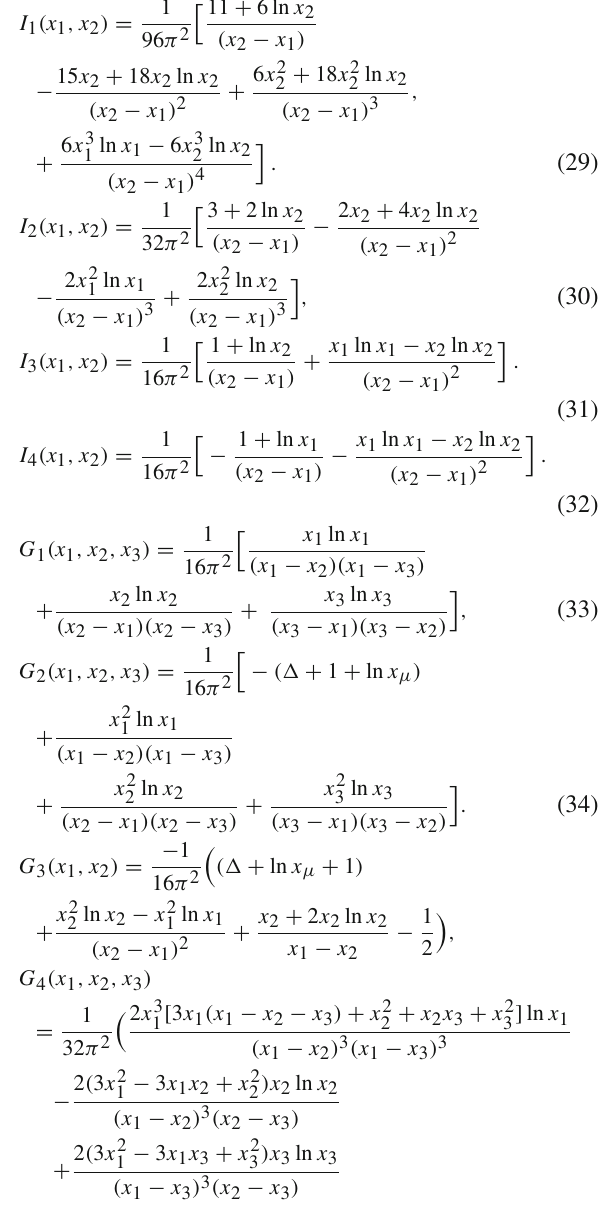
Fig. 10 With m 1 = 500GeV , m 2 = 1000GeV , tan β = 13 , M Lf = 10 4 GeV 2 , tan β L = 2 . 0, and g L = 1 Pb versus V Lt with S 2 m = 5TeV 2 (solid line) and S 2 m = 6TeV 2 (dotted